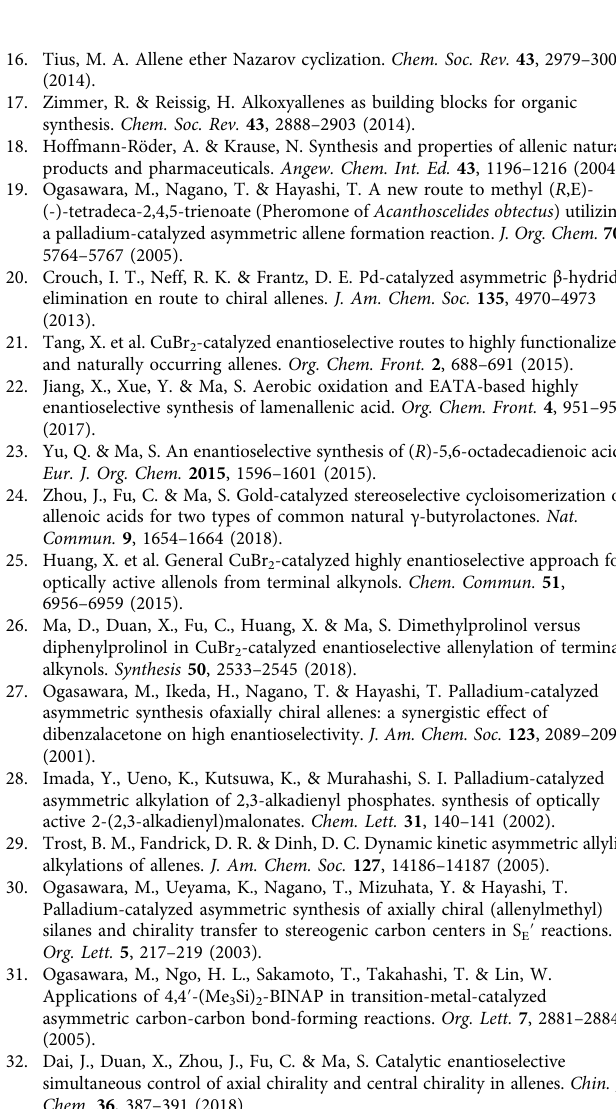
Fig. 6 Asymmetric induction. Proposed mechanism and the model predicting the absolution con fi